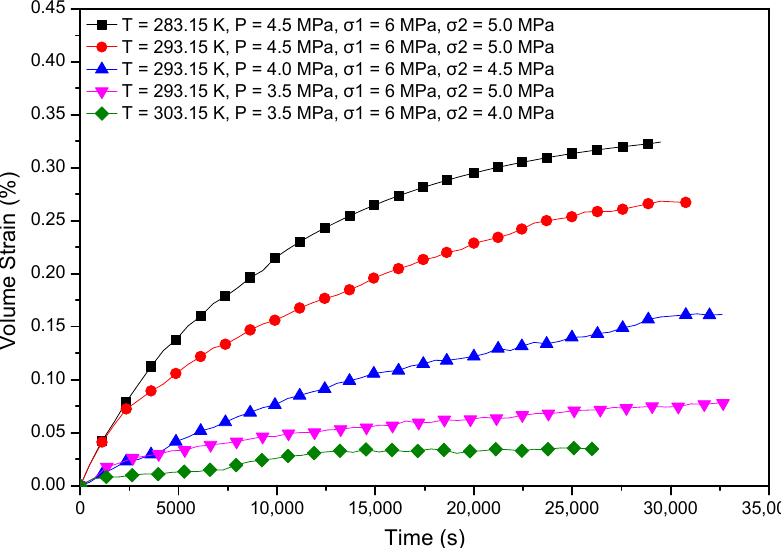
Figure 8. Variation characteristics of volume strain of coal sample with time under different temperature and effective axial stress conditions.